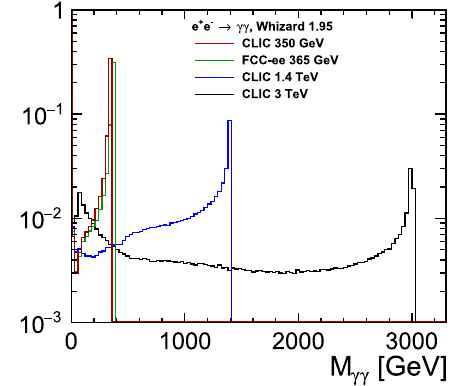
Fig. 4 The distributions of the γγ invariant mass in e + e − → γγ events at 350 GeV, 1.4 TeV and 3 TeV CLIC (red, blue and black histograms, respectively), and at 365 GeV FCC-ee (green